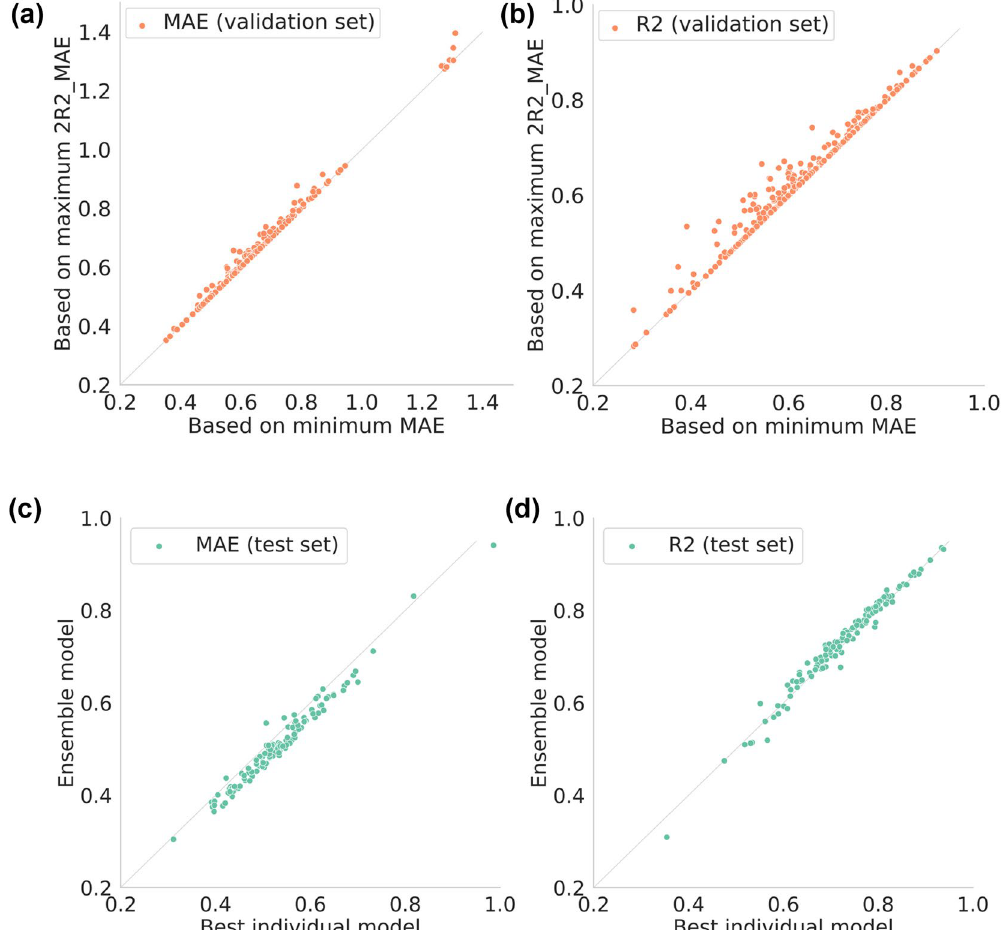
Figure 1. The impact of 2R2_MAE metric-based model selection and ensemble learning on the predictive performance. ( a , b ) Comparison of the MAE ( a ) and R 2 ( b ) given by the hyperparameter sets selected according to the minimum MAE and maximum 2R2_MAE criteria. The points on the diagonal line represent cases in which the same hyperparameter set was selected by both criteria. There is no considerable difference in the MAE values under either criterion. The R 2 values tend to improve when the hyperparameter set is selected by the maximum 2R2_MAE criterion. ( c , d ) Comparison of the MAE ( c ) and R 2 ( d ) for the ensemble and best individual models. Ensemble learning resulted in a decrease in MAE values and a significant increase in R 2